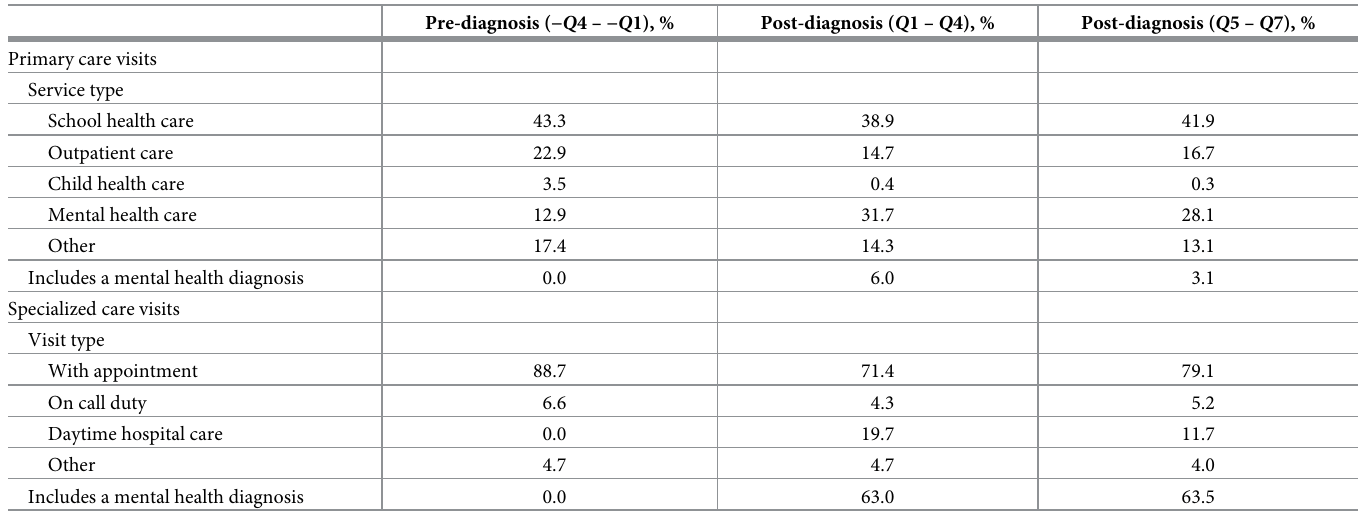
Table 2. Fractions of visits in different health care services types, before and after initial